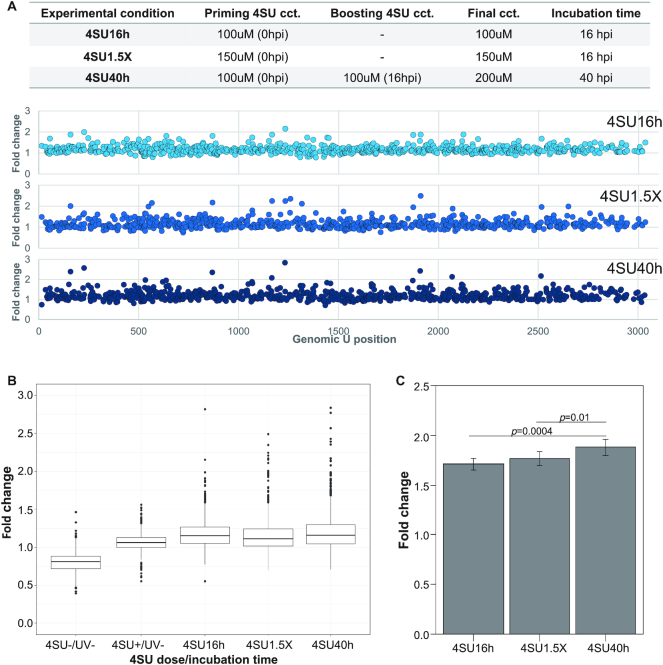
vPAR-CL signal intensities increase with higher 4SU dose and longer incubation time. Using FHV RNA 1 as an example, (A) three experimental conditions were tested for impact to vPAR-CL signals. In each experiment, the priming dose of 4SU was supplemented to cells at the time (0 hpi) of FHV infection (MOI = 1). We observed that the intensities of vPAR-CL signals (i.e. fold change of U-C transition rate between 4SU+/UV+ and 4SU+/UV–) were impacted by 4SU concentration and time of incubation as certain genomic U positions showed higher signals with higher concentration and longer incubation time. We observed good correlation coefficient of vPAR-CL signals under different conditions, indicating reproducibility (Supplemental Figure S3). (B) With or without crosslinking, the average vPAR-CL signals among all 4SU-containing FHVs is similar. However, the outliers of crosslinking groups showed higher signals than control (4SU+/UV–), and the magnitude of outlier signals correlated with 4SU concentration and incubation time. This indicated that 4SU-induced crosslinking only affected certain specific positions on FHV genome. (Whiskers are defined as 1.5× interquartile range (IQR) in all boxplots (Tukey boxplot)). (C) We sampled top 5% vPAR-CL signals from three experiment groups and determined that optimal vPAR-CL signal was achieved under 4SU40h condition, which was therefore applied to all further vPAR-CL experiments. Statistical assays were conducted with standard t-test (two-tailed).